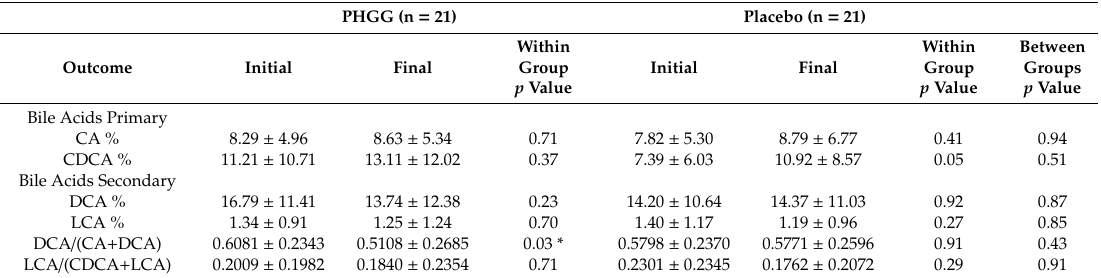
Table 4. Change in plasma bile acids after PHGG intake or placebo in healthy volunteers having a tendency toward diarrhea for 12 weeks. Outcome Initial Final